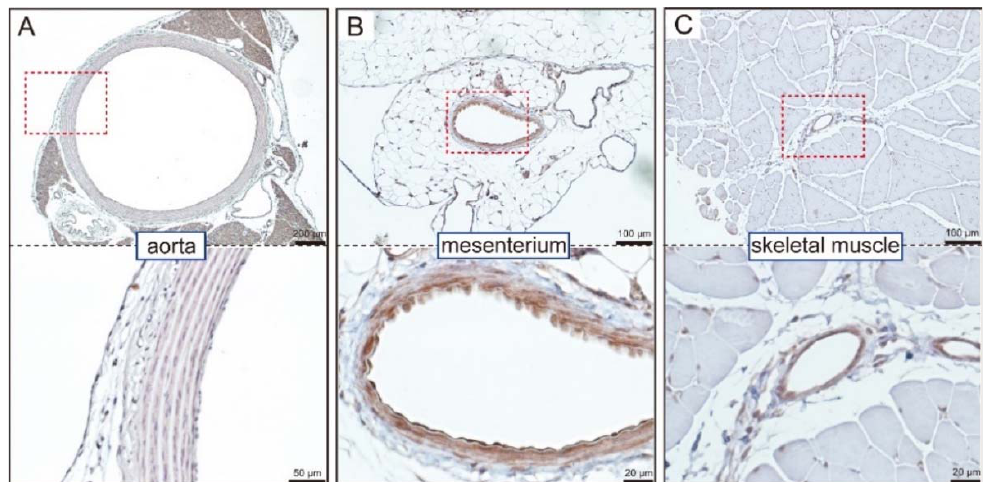
Figure 2. GC-A is abundantly expressed in rat small arteries and arterioles. Localization of GC-A in the aorta ( A ), mesenterium ( B ), and skeletal muscle ( C ) was examined by immunohistochemistry in 4-week-old male Sprague-Dawley rats. The region within the red dotted box in the upper part of each panel is magnified in the bottom part of each panel. This figure is a reconstruction of the figure in our original article [37].